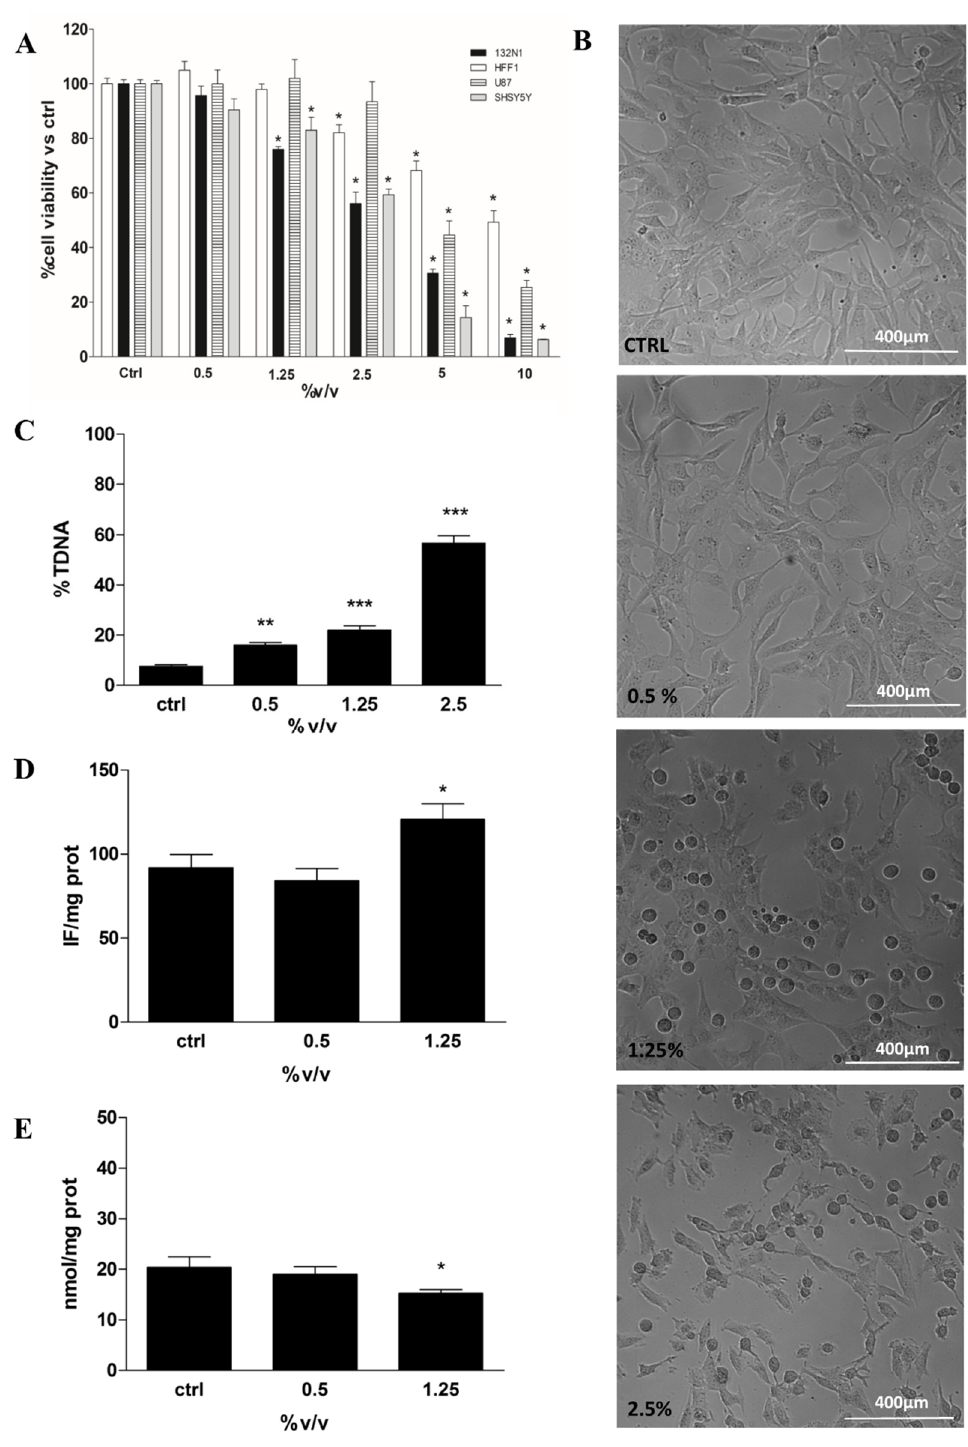
Figure 2. Cell viability, cell morphological analysis, DNA integrity and Redox Status in 1321N1 cells untreated and treated for 24 h with different concentrations of Rapha Myr ® extract depending on each cell-based assay protocol. ( A ) Cell viability in HFF1,1321N1, SHSY5Y and U87 cells evaluated by MTT assay. The results were expressed as a percentage of cell viability compared to untreated control viable cells, which had a value equal to 100%. ( B ) Representative images of 1321N1 cell morphology acquired by optical inverted light microscopy. Original magnification 10×, scale bar 400 µm. ( C ) DNA damage was evaluated by alkaline comet assay. The results were expressed as the percentage of DNA present in the comet tail (%TDNA). ( D ) Intracellular reactive oxygen species (ROS) levels evaluated